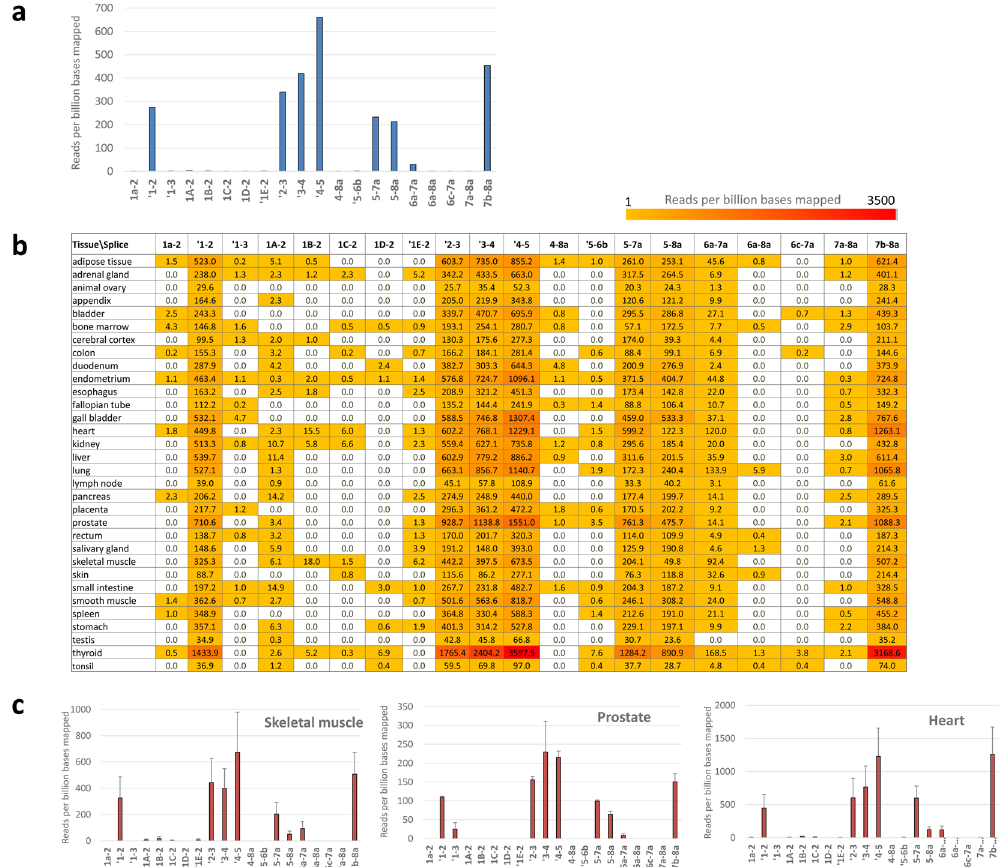
Figure 6. Occurrence of novel splicing events across different tissues. ( a ) All splice sites supported by 20–200 uniquely aligned reads from all datasets combined are listed and the number of reads per million aligned to each indicated. ( b ) The pattern of splice site use across different tissues (dataset 2) is indicated by the number of reads containing each site per billion bases mapped. ( c ) Examples of differential splice site use across